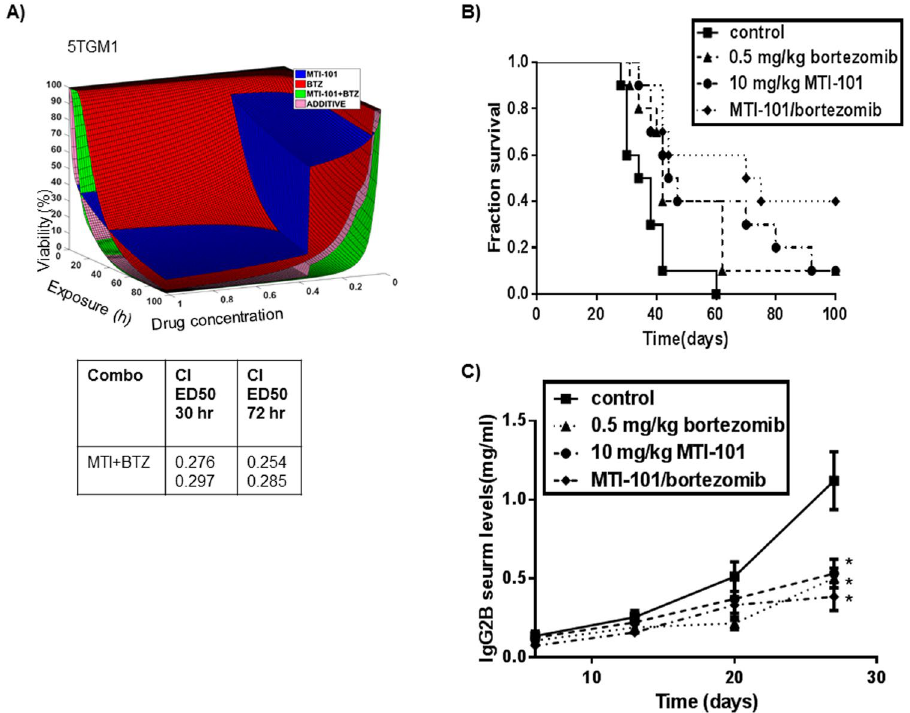
Figure 5. Combination treatment with MTI-101 and bortezomib augments survival in vitro and in vivo . ( A ) 5TGM1 cells were treated with varying concentrations of MTI-101, bortezomib or the combination of both drugs for 72 hours using a bone marrow stroma model as described in materials and methods. Combination indexes (CI) for duplicate wells were calculated at 30 and 72 hrs. ( B ) 1 × 10 6 5TGM1 MM cells were injected into 6–8 week old C57BL/KaLwRijHsd mice via tail vein. At day 10, mice were treated with 10 mg/kg of MTI-101 and/or 0.5 mg/kg bortezomib three times a week for three weeks (10 mice per group). Mice were monitored daily for survival. Mean survival times for vehicle control, bortezomib only ( p < 0.02, log-rank sum), MTI- 101 only ( p < 0.01, log rank sum), and MTI-101/bortezomib ( p < 0.001, log rank sum) combination therapy were 36, 42, 45.5, and 72.5 days, respectively. ( C ) IgG2B serum levels were measured by ELISA once a week for 4 weeks to determine myeloma levels in the peripheral blood. At day 28 all drug treatment groups showed a significant decrease in IgG2B levels compared to control animals (p <